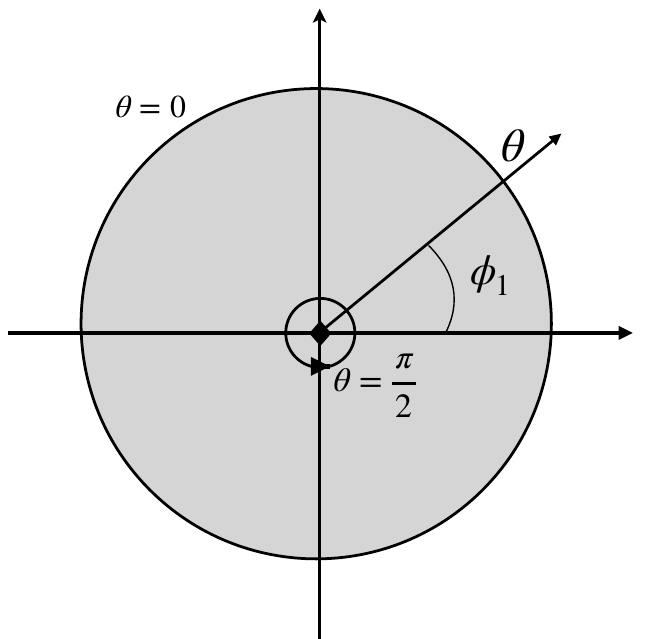
Figure 1 . The topology of the space transverse to the defect is a disk. At the center of the disk we have θ = π and at the boundary of the disk we have θ = 0 2